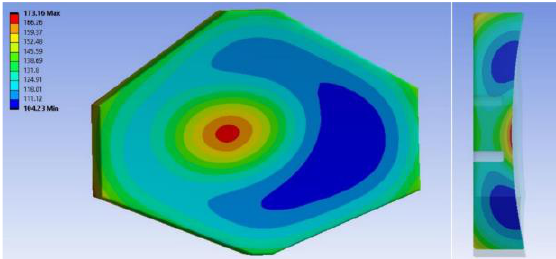
Fig. 5. ANSYS model of a simplified mirror geometry, showing the maximum temperature (~170°C) reached after ratcheting with a graphite mirror with a copper coated front face. Left – front view, right - cross section